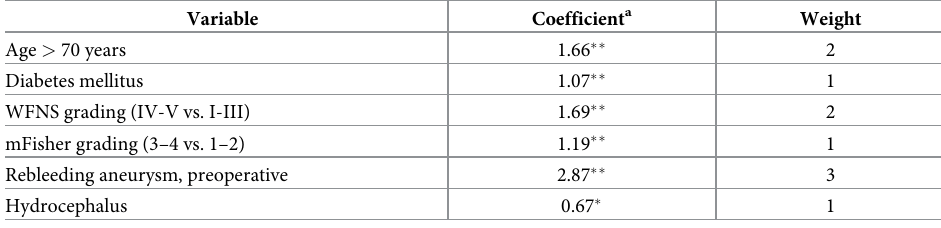
Table 3. Scoring system for the prediction of poor outcome at one